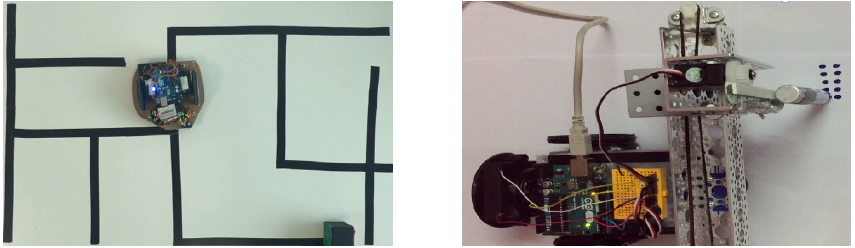
Fig. 2. A maze solving robot and a pixel-wise drawing robot.